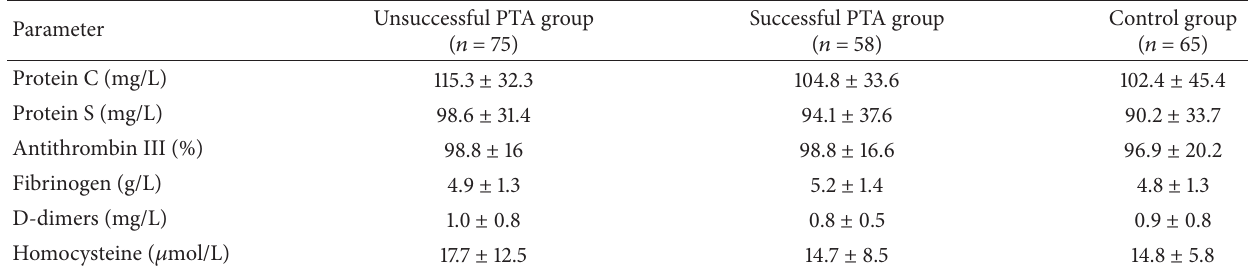
Table 2: Mean values of coagulation factors among the groups ∗